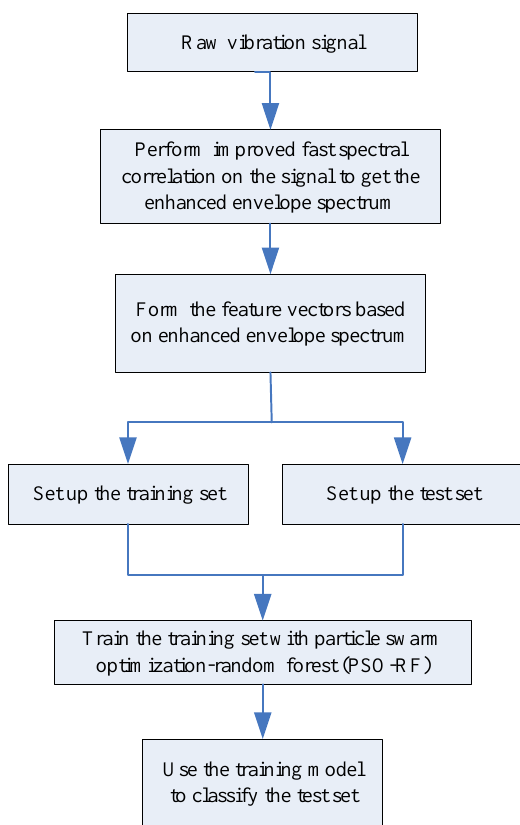
Figure 5. Flowchart of the presented method.